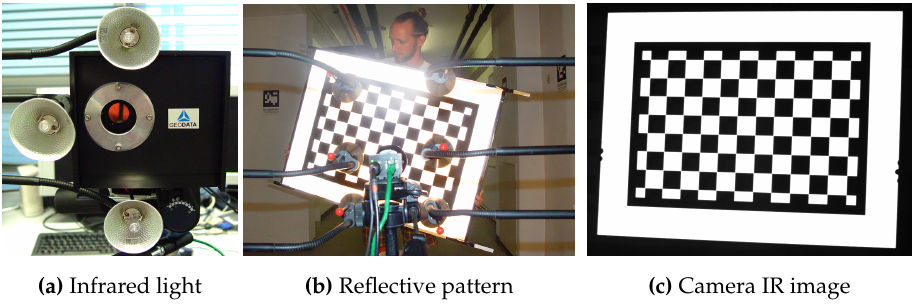
Figure 5. Intrinsic camera calibration with a retro-reflective